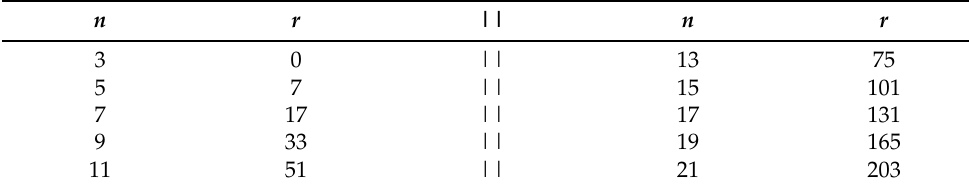
Table 2. Degree Elevation r for Degree n